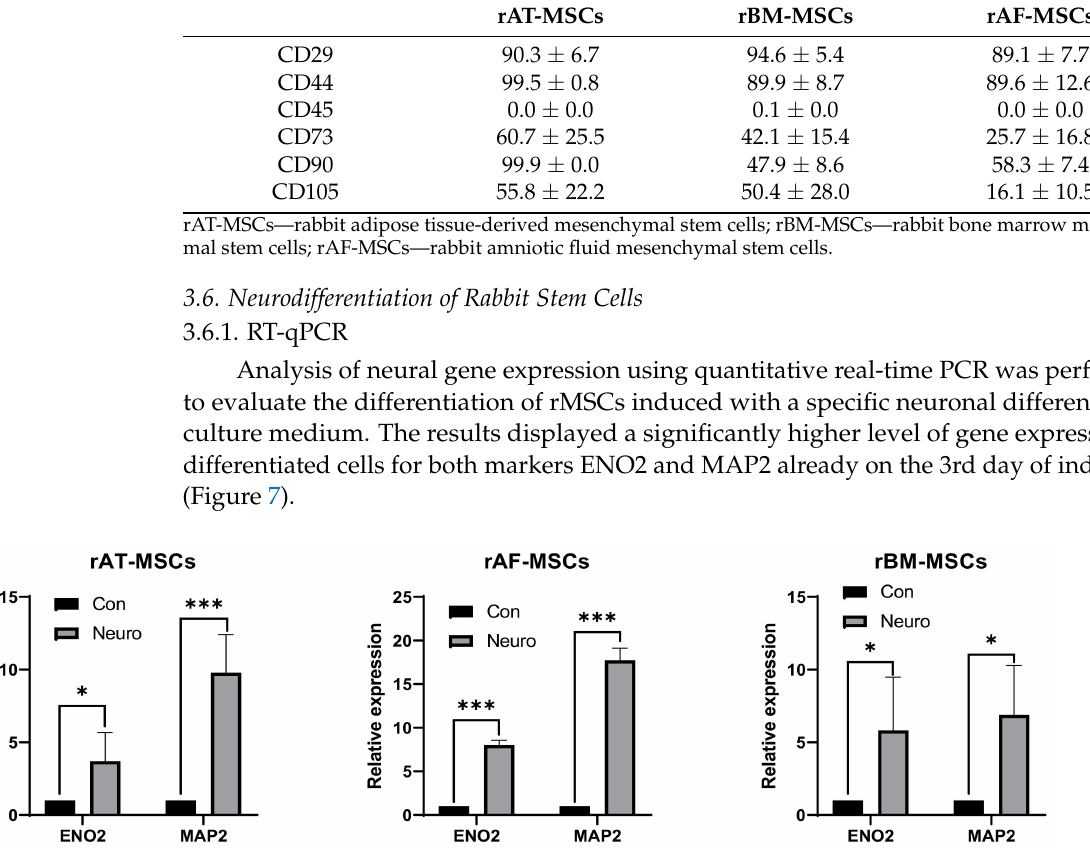
Figure 7. Results of neural marker gene expression using RT-qPCR. * p < 0.05; *** p < 0.001; Con—control (non-induced sample), Neuro—neurodifferentiated sample; rAT-MSCs—rabbit adipose tissue-derived mesenchymal stem cells; rAF-